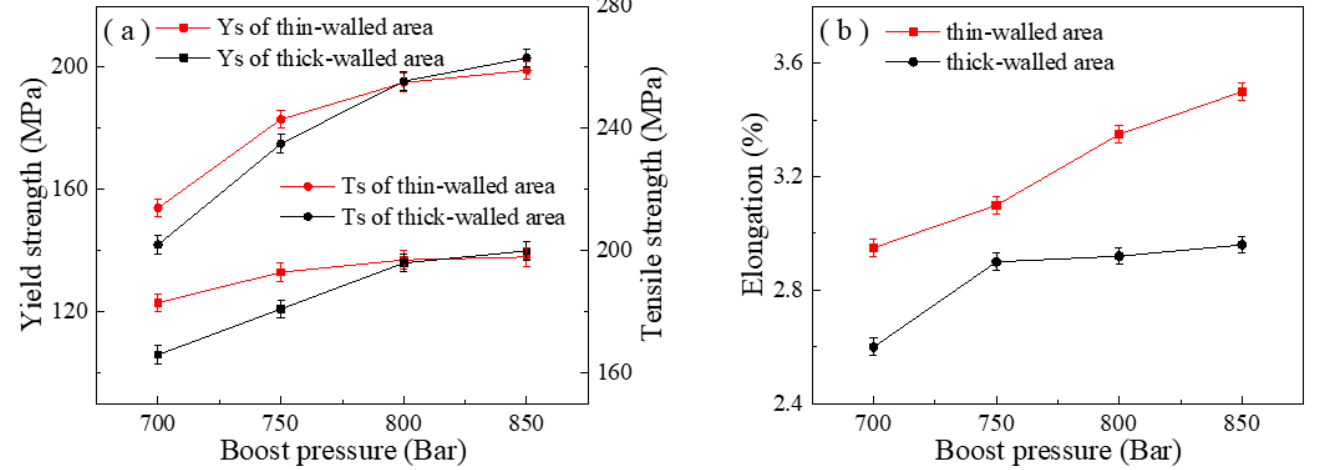
Figure 3. Mechanical properties: ( a ) Ys and Ts, ( b ) elongation of castings with different wall thick- nesses under different boost pressures.